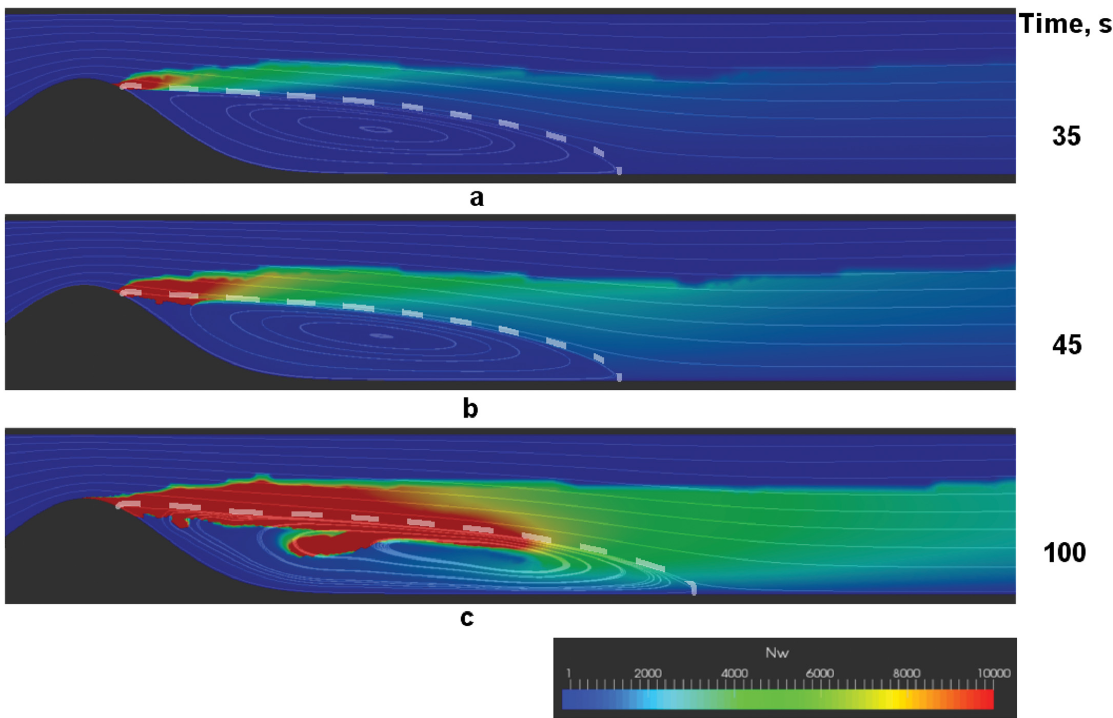
Fig 5. Successive stages of a friable floating fibrin structure formation. a — thrombus nucleation, b — formation of fibre-like fibrin structure, c — thick and friable floating fibrin structure. Shown are the color maps of N w — the weight-average number of monomers in fibrin-polymer in the vessel, with red areas (cid:6) N s ). Streamlines are plotted to visualize the fl ow, and the separatrix is shown with a dashed line. representing regions of fibrin gel formation ( N w w ~ ¼ 0 : 4 ~ ¼ 12 Parameters used in these simulations are: Re = 180, h = 0.6, d , d . Note that only a fragment of the vessel closest to the plaque is depicted.